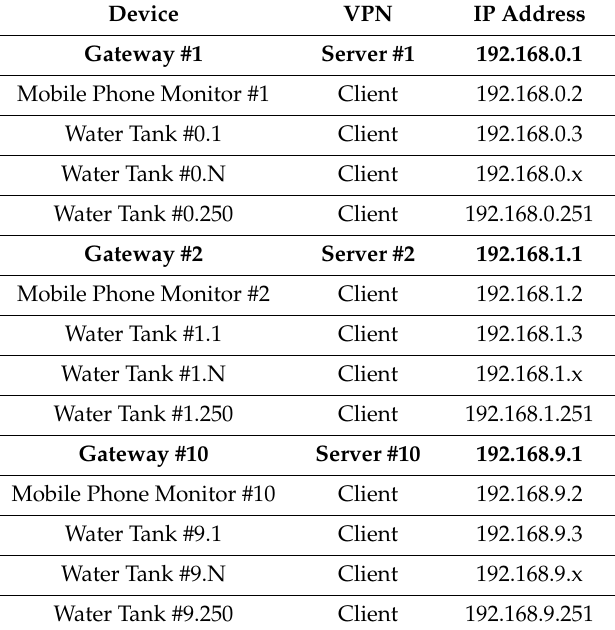
Table 1. VPN server-client configuration for a secure, scalable IoT deployment of the case